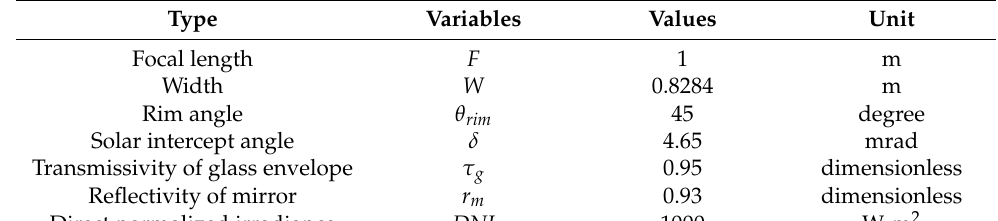
Table 2. Parameters of the PTC system.